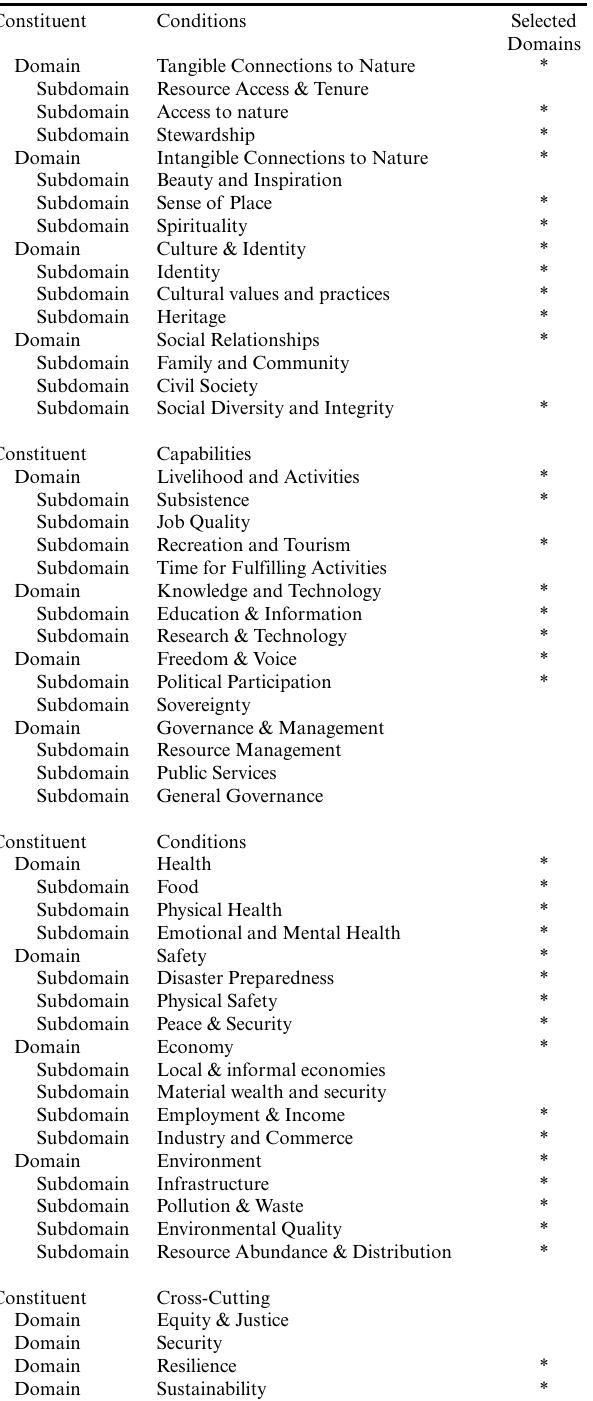
Table 1 . List of human well-being categories, adapted from Breslow et al.